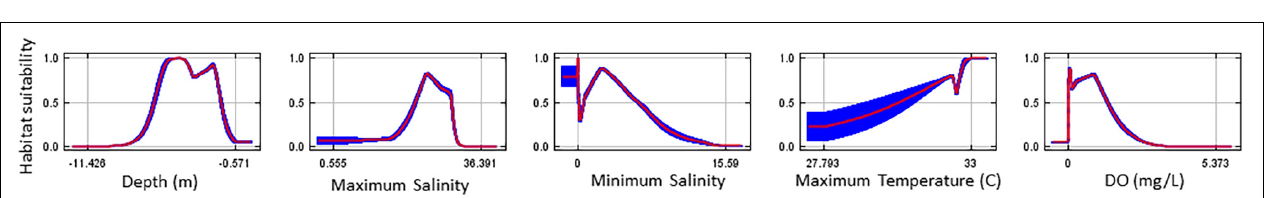
FIGURE 5 | Minimum daily dissolved oxygen per oyster year.